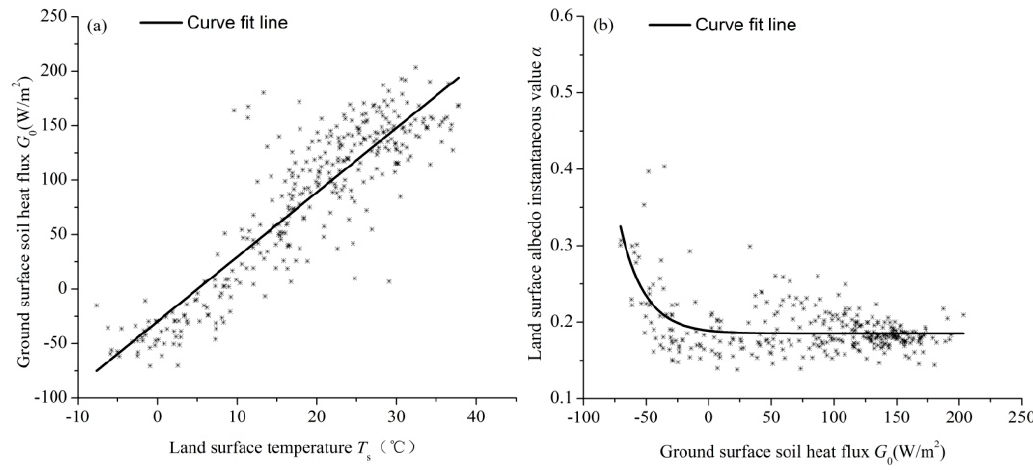
Figure 12. The relationship between the “observed” G 0 and the measured land surface temperature T s ( a ) and the relationship between the “observed” G 0 and the measured land surface albedo α ( b ) at the TGL station on sunny summer days of